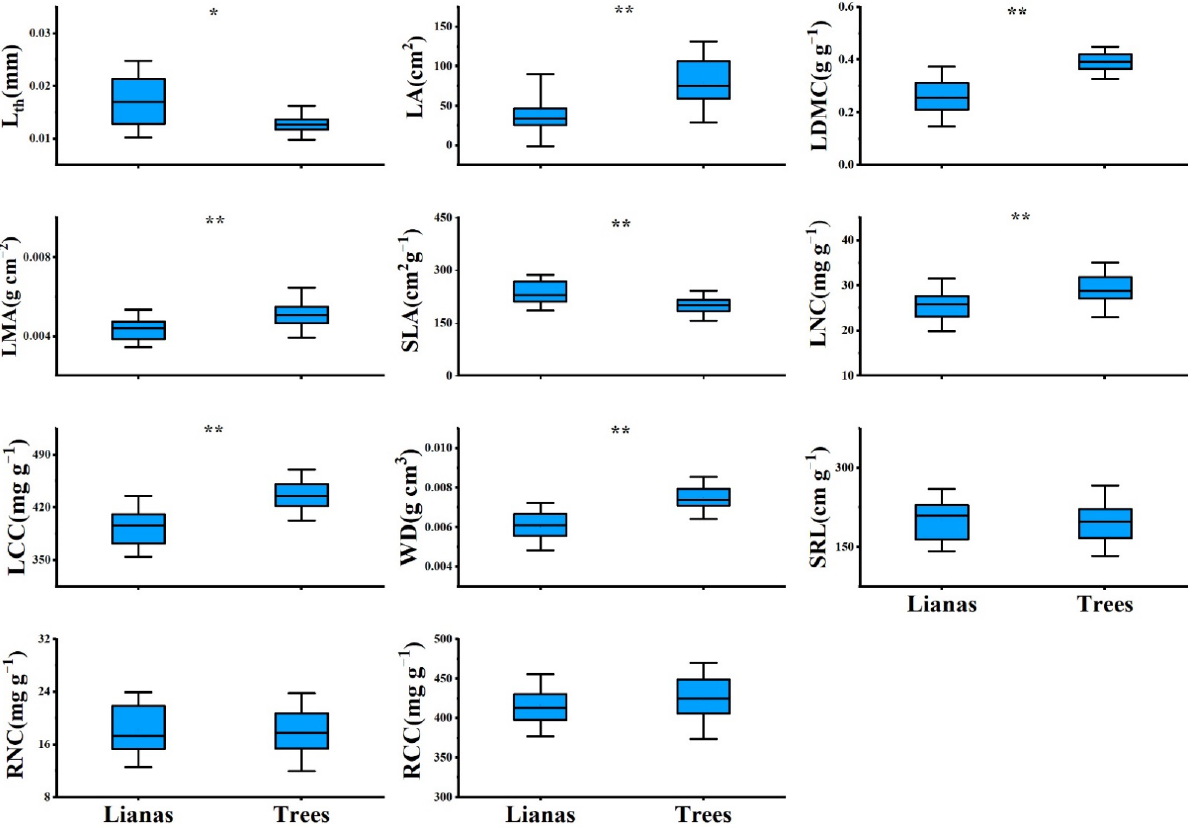
Figure 2. Leaf, stem, root traits of lianas and host trees based on 61 liana-host tree pairs in temperate forest of China. Asterisks indicate statistically significant difference between lianas and host trees at α < 0.05 (*) and α < 0.001 (**). For explanation of abbreviations, see Table 1.